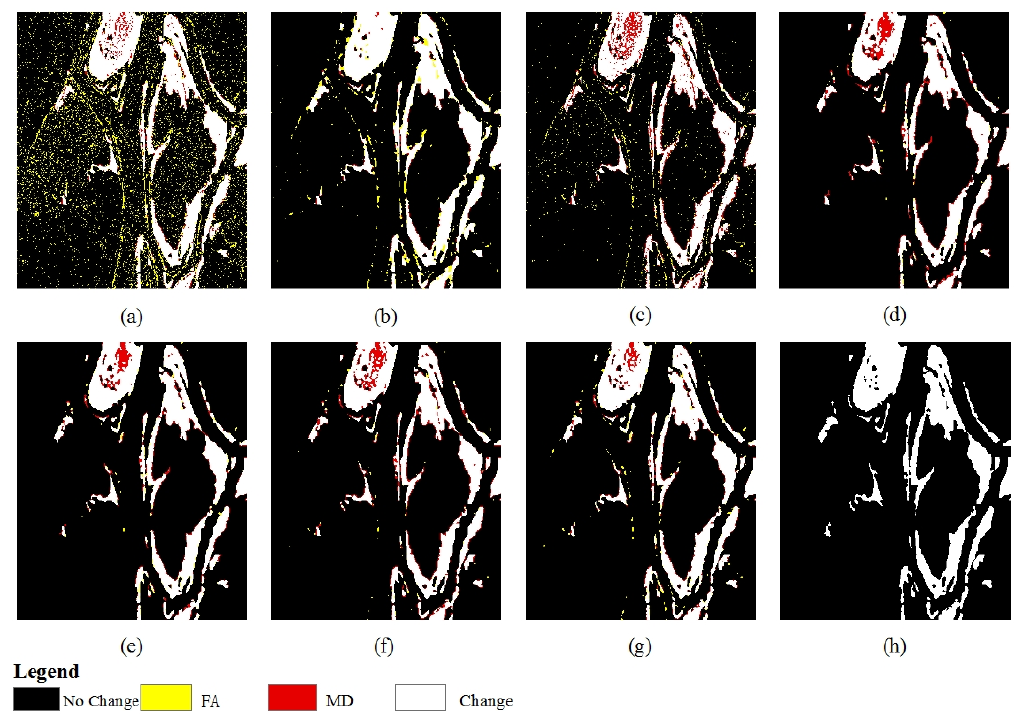
Figure 9. Final change detection maps of the Ottawa dataset produced by ( a ) EM; ( b ) EMMRF; ( c ) FCM; ( d ) FLICM; ( e ) RFLICM; ( f ) sRSFCM; ( g ) proposed RSFCM; and ( h ) reference image.